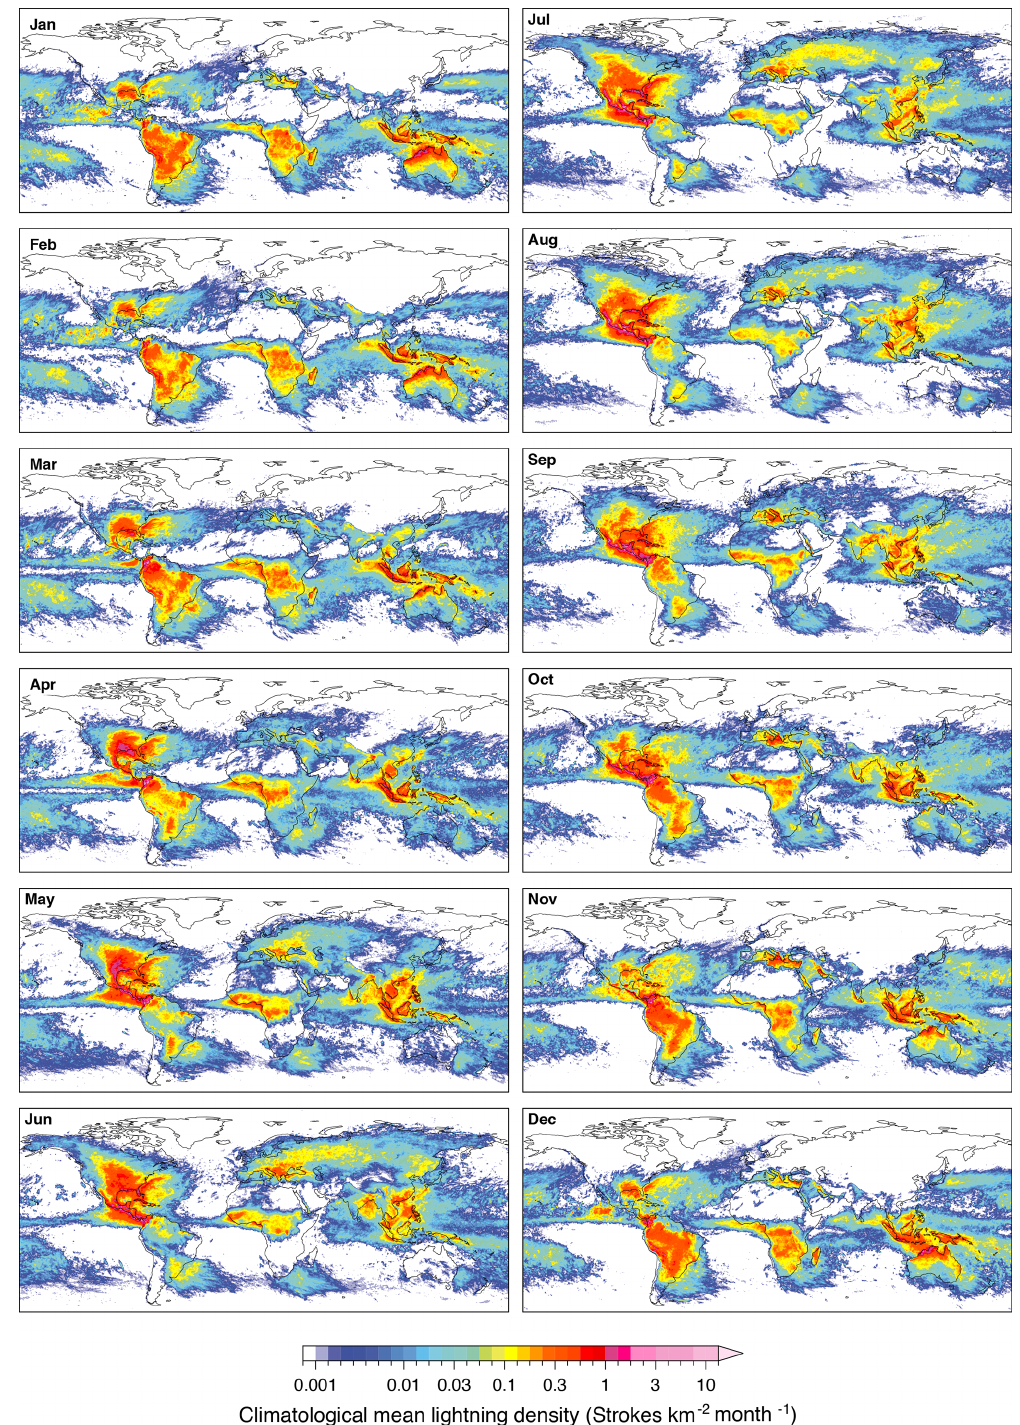
Figure 7. Climatological monthly mean global lightning stroke density (2010–2020).